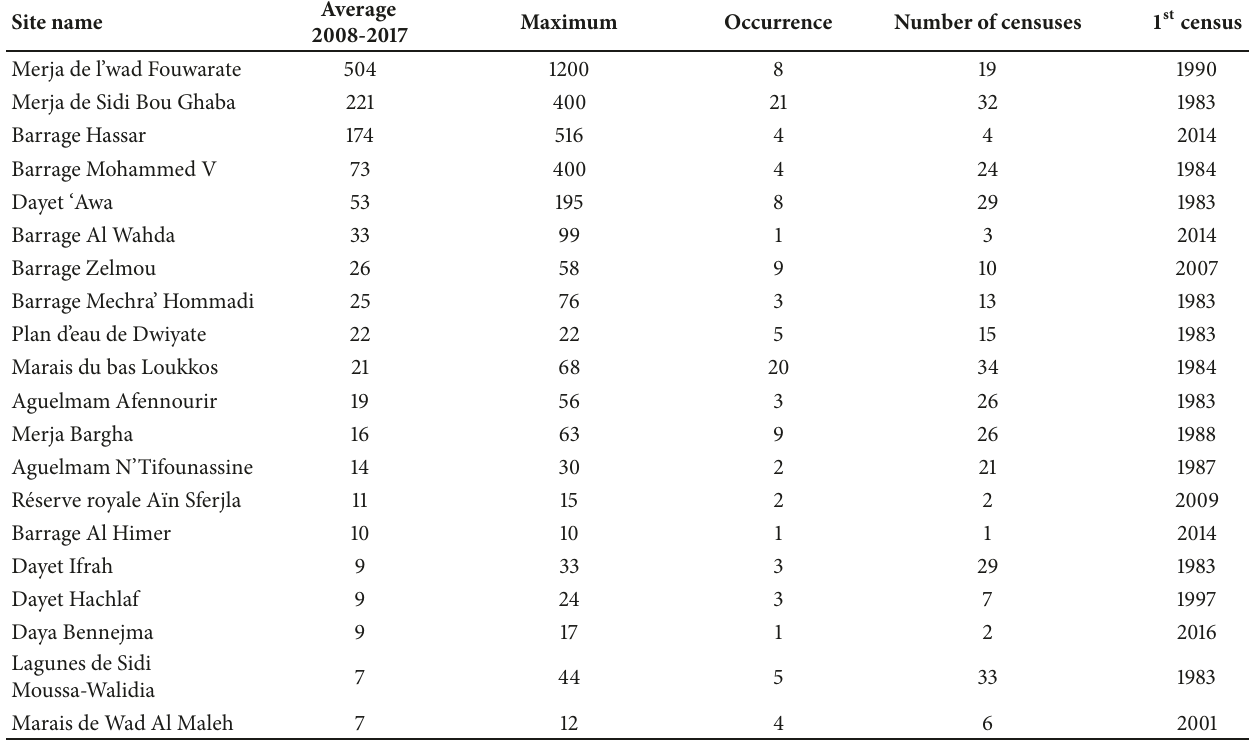
Table 1: Most important wintering sites of the Ferruginous duck.